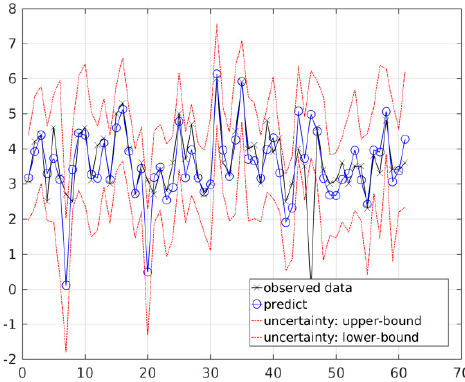
Figure 11. The Kriging interpolation contour map. The red and black symbols are the logging well with and without gold mine, respectively.